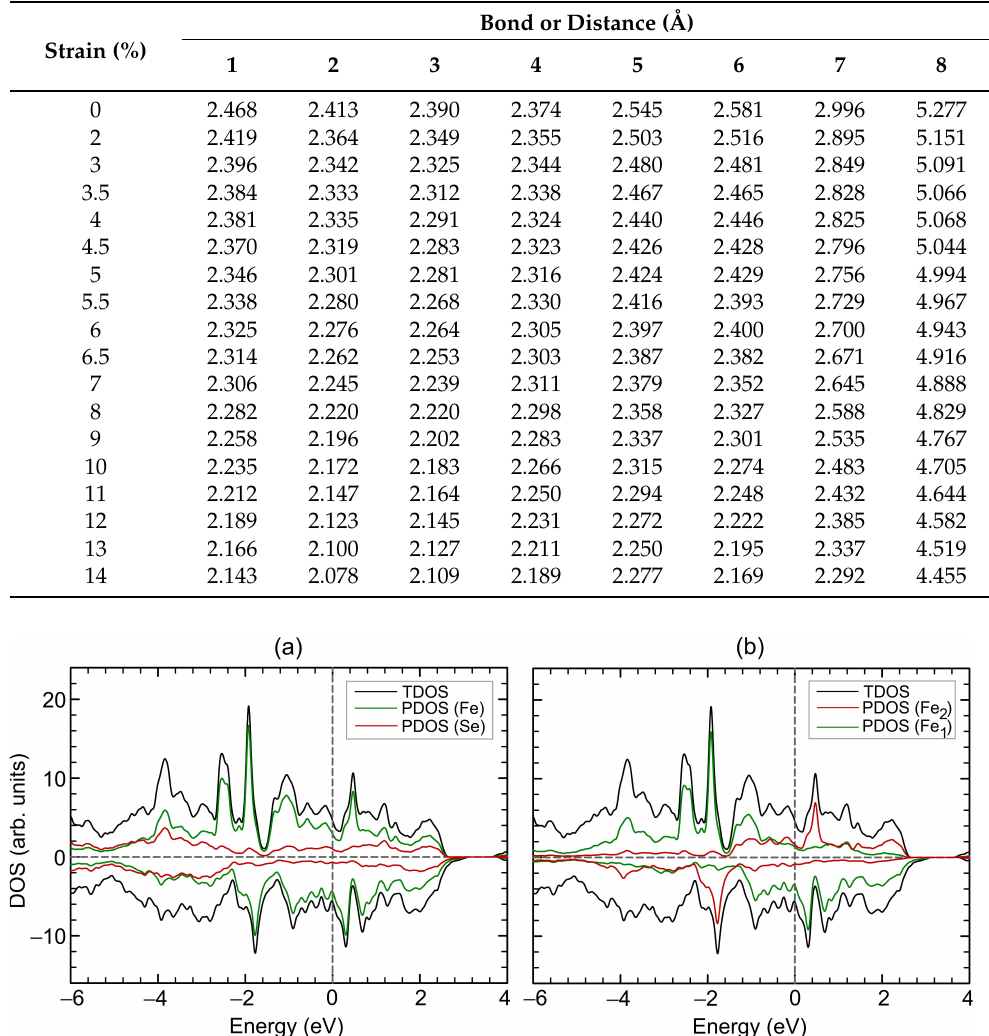
Table 2. Bond lengths (Å) and distance (Å) between Se atoms closest to the iron vacancy of the Fe 3 Se 4 monoclinic phase. The atomic numbering scheme is shown in Figure 1a.